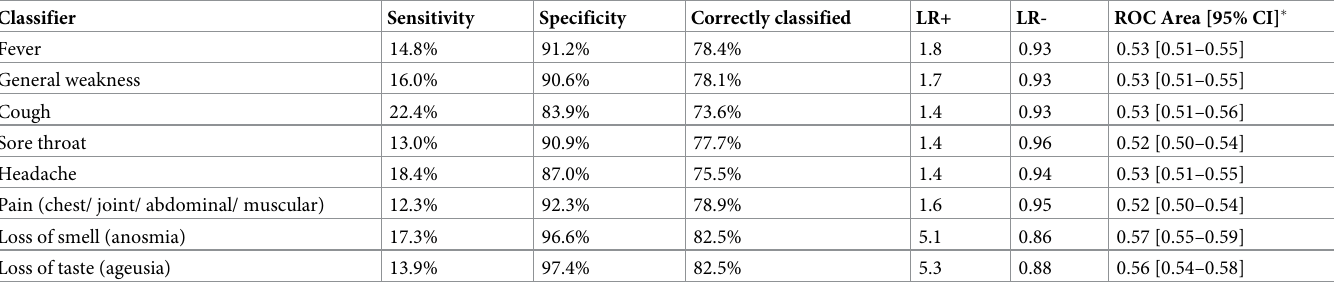
Table 3. Receiver operator characteristics of factors.